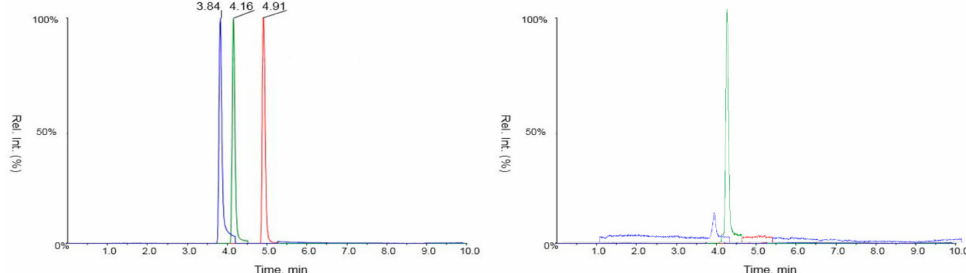
Figure 2. LC-MS chromatograms of the mixture of psoralene (R t = 3.84 min), 5-methoxypsoralene (R t = 4.16 min), and imperatorin (R t = 4.91 min) (left) and of a fennel extract